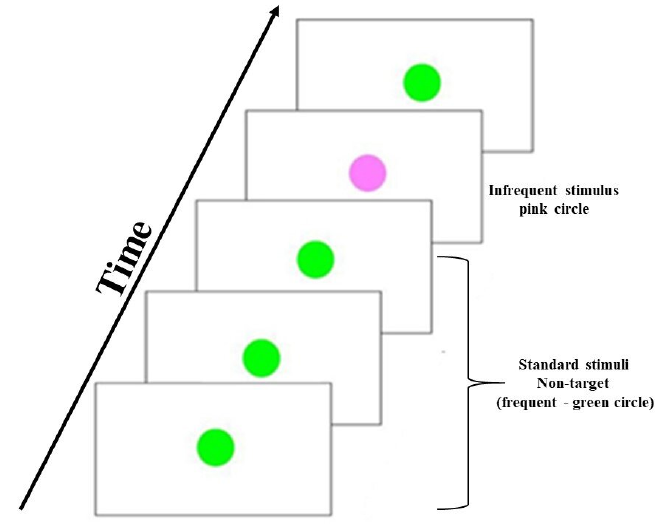
Figure 2. The temporal sequence of the oddball visual task. The green-colored circle stimulus is the “frequent” or “standard” stimulus. The pink-colored circle is the “rare” or “deviant” or “target” stimulus. The number of standards presented between two deviants is pseudo-random [40].